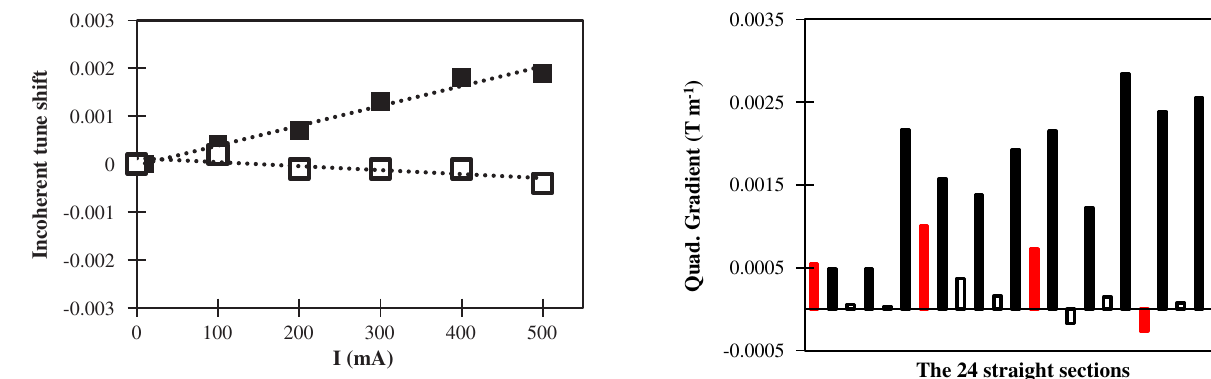
FIG. 4. Equivalent quadrupole gradient calculated by LOCO (300 mA case) for each of the 24 straight sections: long (red), medium (black) and short (white).